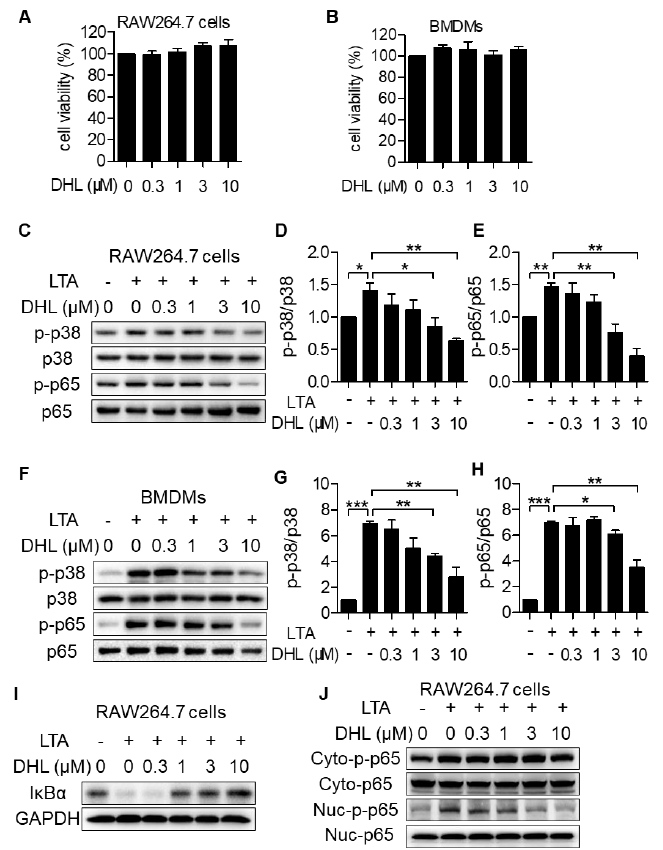
Figure 1. DHL reduces p38 MAPK and NF−κB phosphorylation in LTA−induced RAW264.7 cells and primary BMDMs. ( A , B ) CCK8 measurement of cell vitality. RAW264.7 cells ( A ) and BMDMs ( B ) were treated with different concentrations (0, 0.3, 1, 3, and 10 μM) of DHL for 24 h. RAW264.7 cells ( C – E , I ) and BMDMs ( F – H ) were pretreated with DHL at 0, 0.3, 1, 3, and 10 μM for 0.5 h, then stimulated with LTA (20 μg/mL) for another 0.5 h. Cell lysates were collected, and the protein ex- pression levels of p-p38, p38, p-p65, and p65 were evaluated by Western blot. The ratios of p- p38/p38 ( D , G ) and p-p65/p65 ( E , H ) were semiquantitatively analyzed by ImageJ software. ( I , J ) RAW264.7 cells were pretreated with DHL at 0, 0.3, 1, 3, and 10 μM for 0.5 h, then stimulated with LTA (20 μg/mL) for another 0.5 h. Cytoplasm and nuclear fractions were extracted and subjected to immunoblot analysis using IκB antibody, p-p65 antibody, and p65 antibody. Results are represented